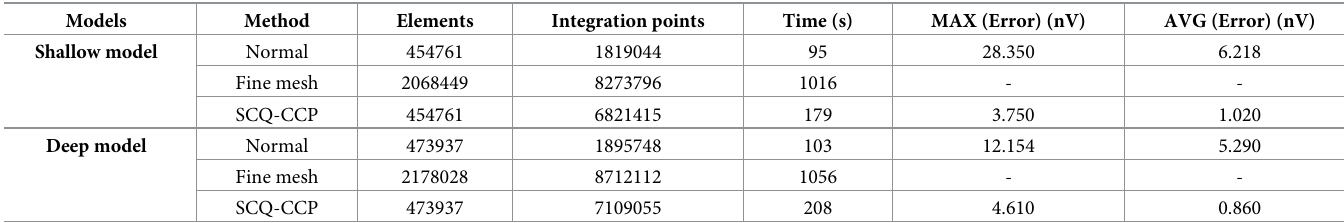
Table 2. Computational time and space